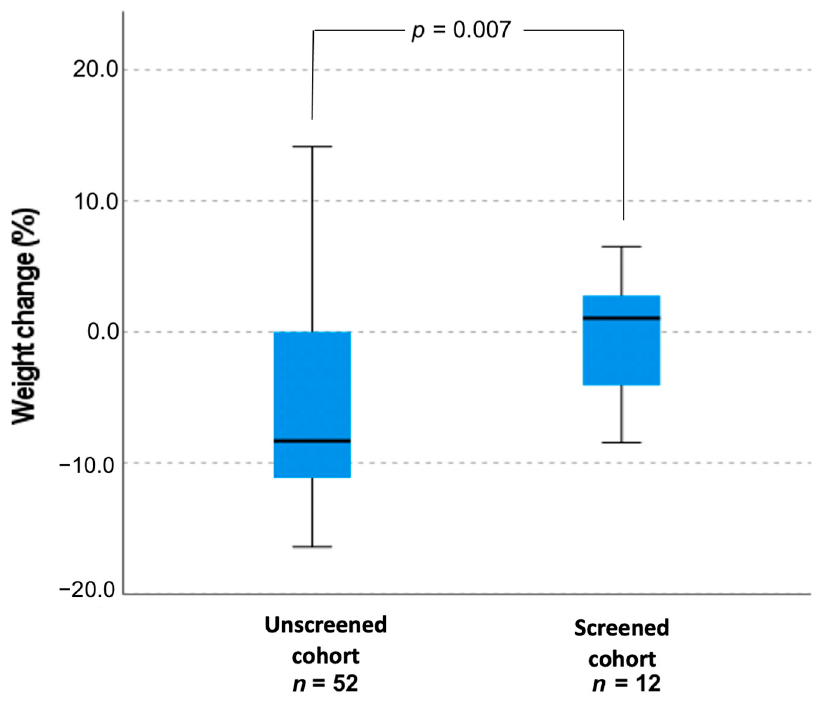
Figure 2. Weight change (%) in unscreened and screened patients’ cohort with SW CAH. On the day of diagnosis, serum potassium levels in unscreened all cohort and sepa- rately in males’ group were higher, although not statistical significantly, than in screened cohort (6.9 ± 1.6 versus 6.7 ± 1.3, p = 0.79 and 7.7 ± 1.5 mmol/L versus 6.89 ± 1.5 mmol/L, p = 0.33 respectively). Hyperkalemia (>6.9 mmol/L) occurred in 63.6% of patients in the unscreened males’ cohort and in 55.5% of screened males, p = 0.65. No significant correlation was observed between serum potassium levels and days when CAH was con- firmed ( r = 0.202, p = 0.195). Serum sodium levels were 124.5 ± 9.7 mmol/L (102–138) in the unscreened males and 126.31 ± 8.99 mmol/L (111–135.8) in screened males, p = 0.64; hyponatremia (<130 mmol/L) was determined in 72% and 55% of unscreened and screened newborn’s males, respectively, p =